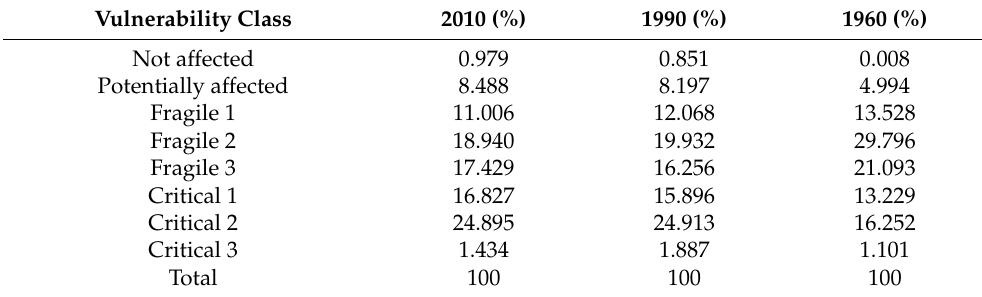
Table 3. Partition of land vulnerability in eight classes for the time points 1960, 1990, and 2010.